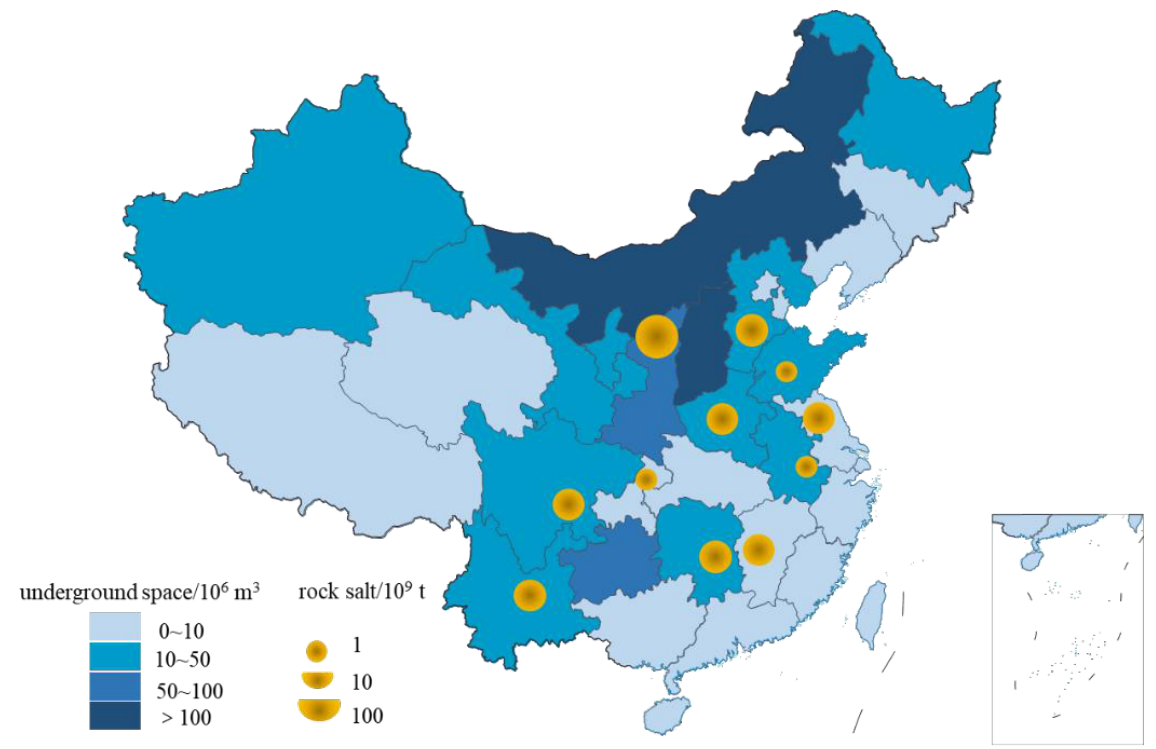
Figure 3. Estimates of underground space as of 2020 and distribution of proven rock salt reserves.